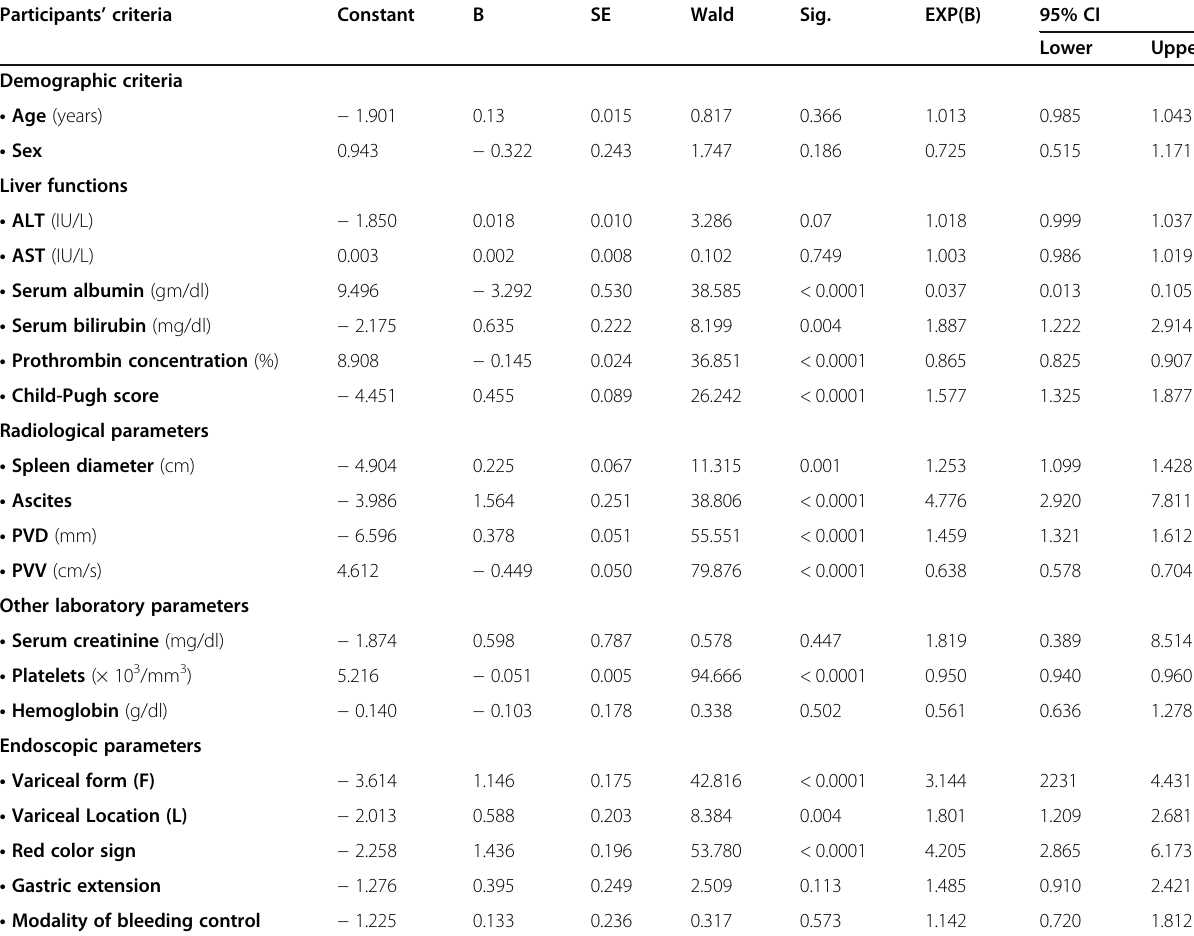
Table 2 Univariate logistic regression analysis for the evaluated predictors Participants ’ criteria